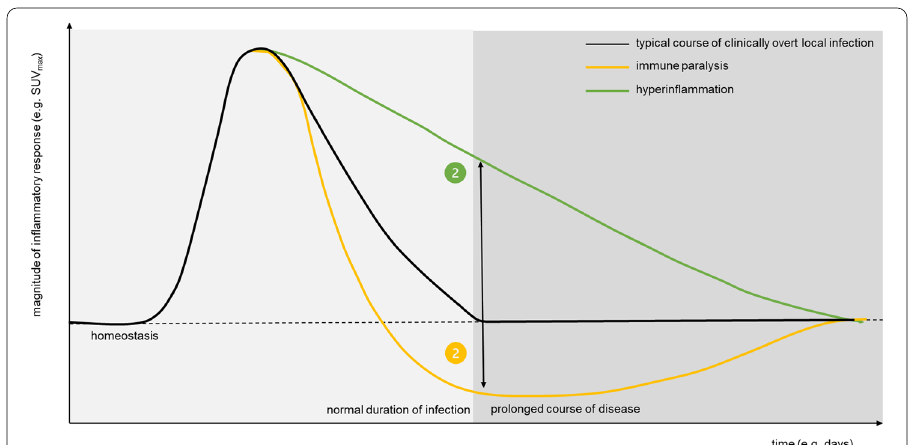
Fig. 3 Artificial intelligence to predict